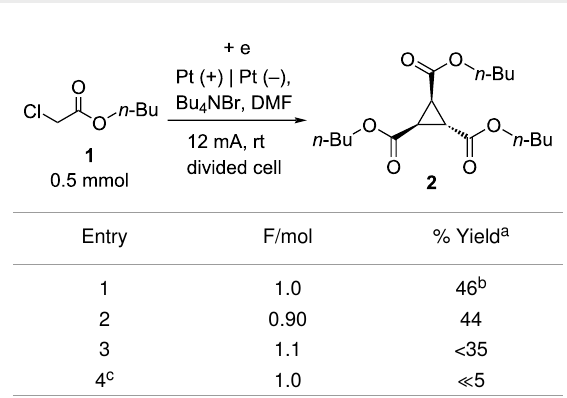
Table 2: Effect of electricity around 1 F/mol and type of electrochemi- cal